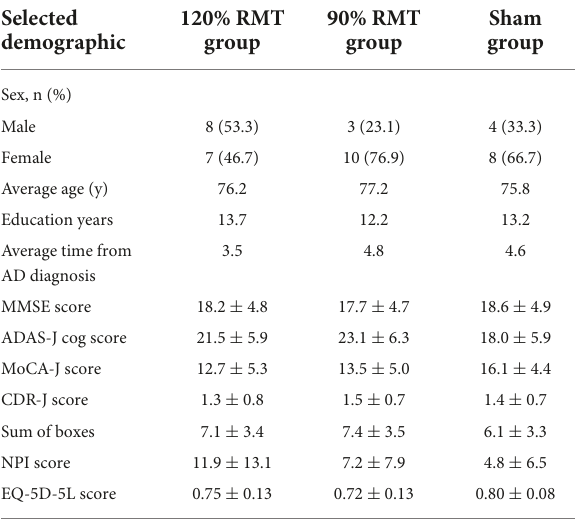
TABLE 1 Selected demographics of the